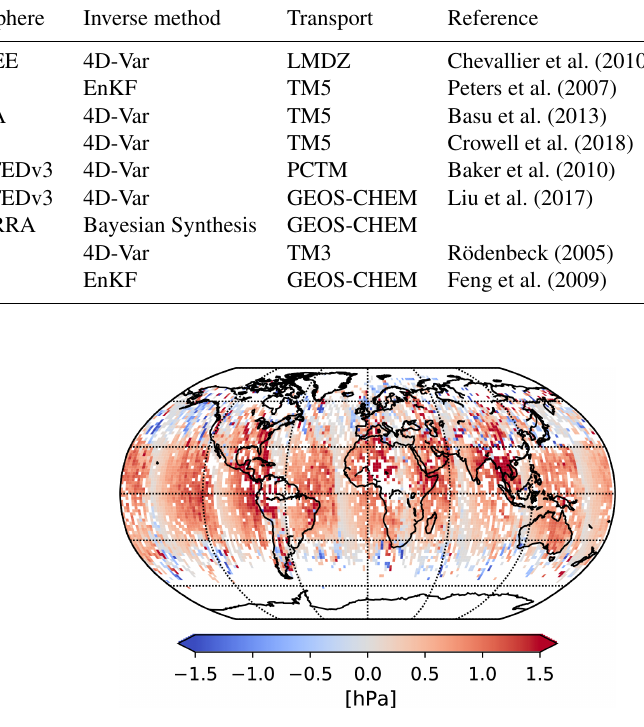
Figure 8. Mean difference between v9 and v8 (v9–v8) surface pres- sure prior for April 2016. Data are aggregated into 2 ◦ × 2 ◦ latitude– longitude square